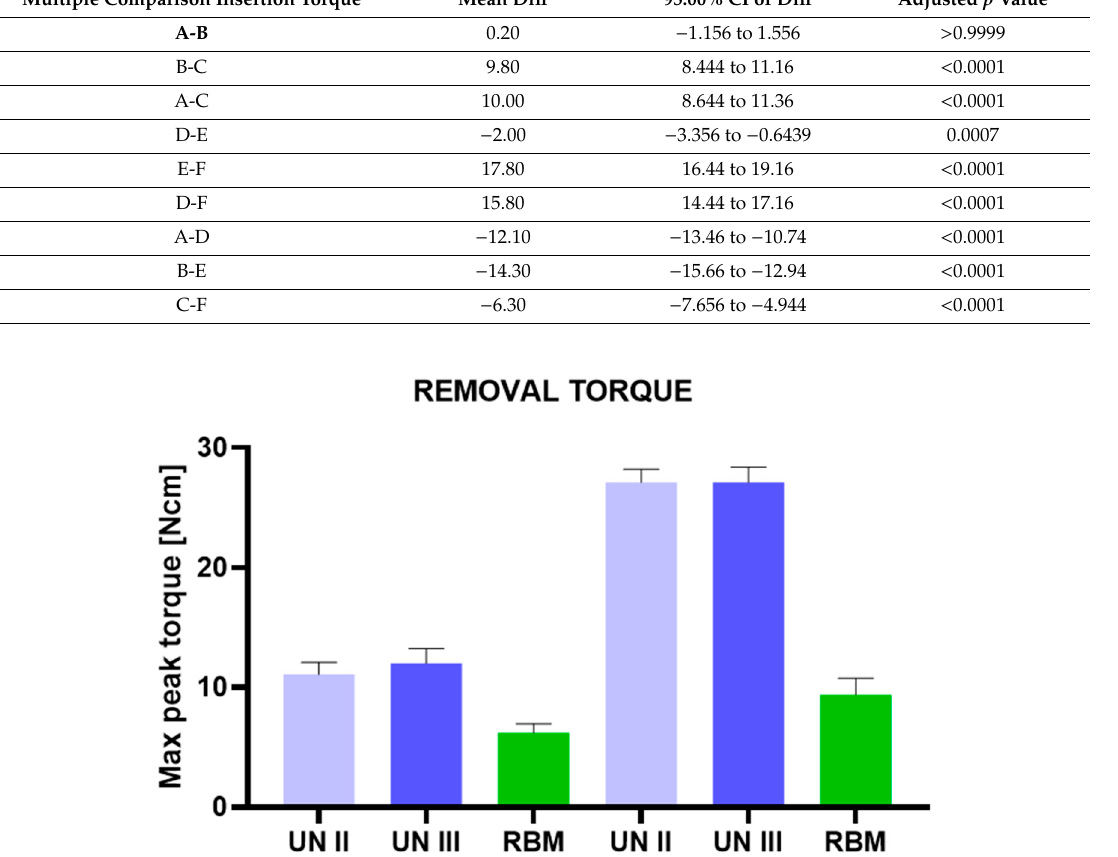
Figure 5. Removal torque of UN II, UN III, and RBM implants in polyurethane foam blocks (10 pcf; 20 pcf). Table 3. Summary of the removal torque values of the different experimental groups.